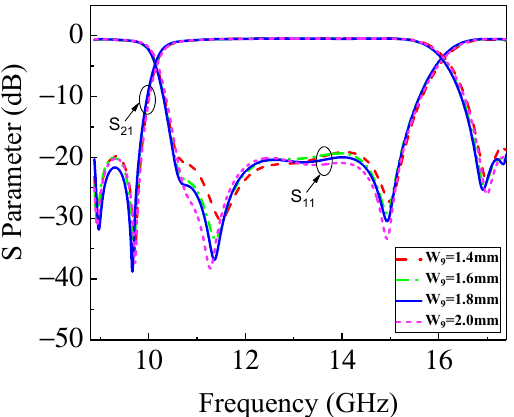
Figure 8. Simulation of S parameters when the DGS slot width W 9 is varied from 1.4 mm to 2 mm, with a step of 0.2 mm increment.